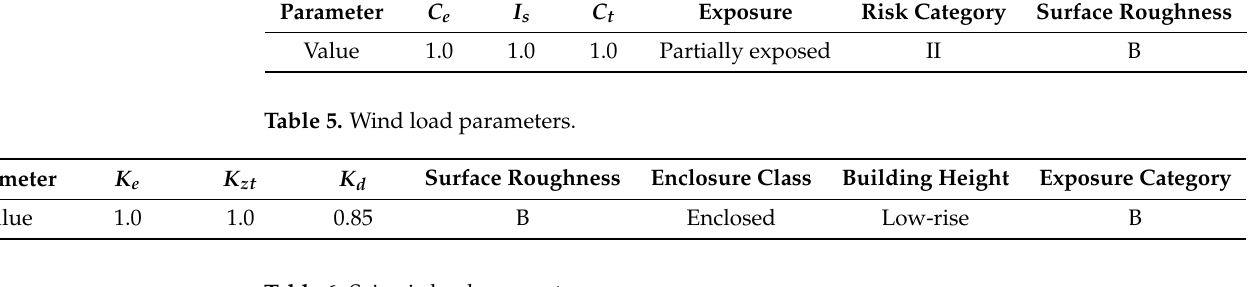
Table 6. Seismic load parameters.